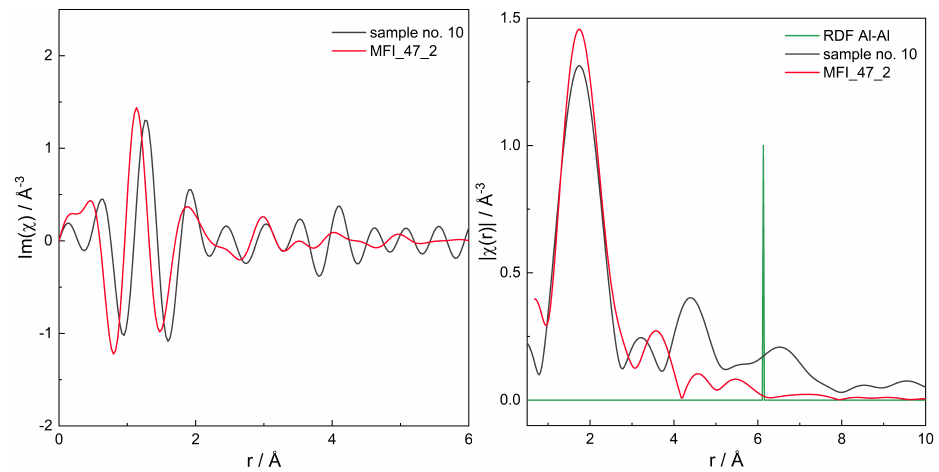
Figure 11. Spectrum of µ ( E ) ( upper left panel ), k 2 χ ( k ) ( upper right ), (cid:61) χ ( r ) ( lower left ), and | χ ( r ) | ( lower right ) for sample no. 10 (MFI of Si/Al = 25) and simulation for computational model labelled MFI_47_2. Matching RMS = 0.0658. The simulation model characterised by Al–Al distance of: 6.1 Å.